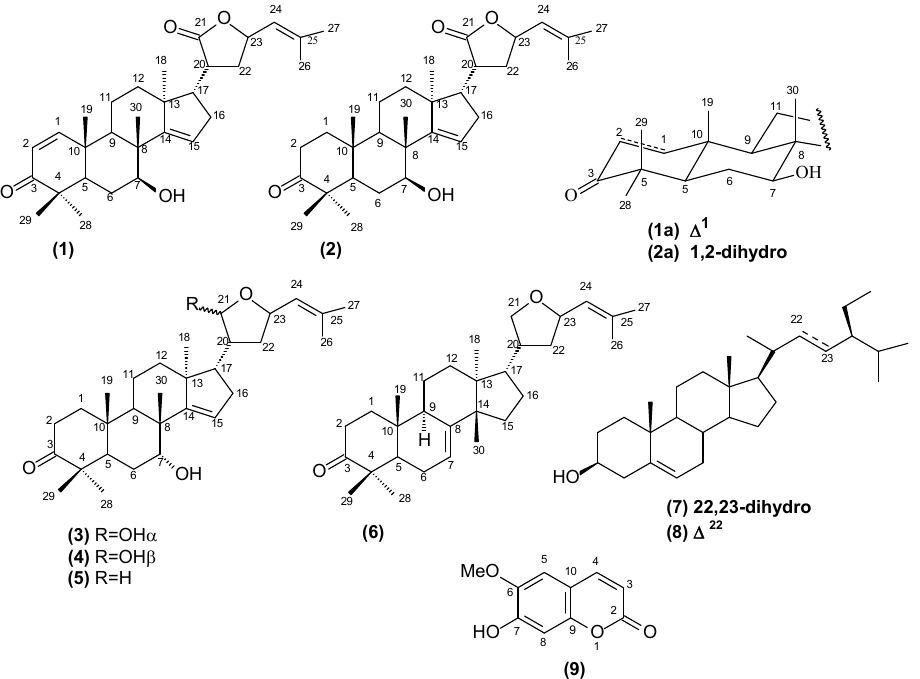
Figure 1. Chemical structures of the compounds isolated from T. lepidota